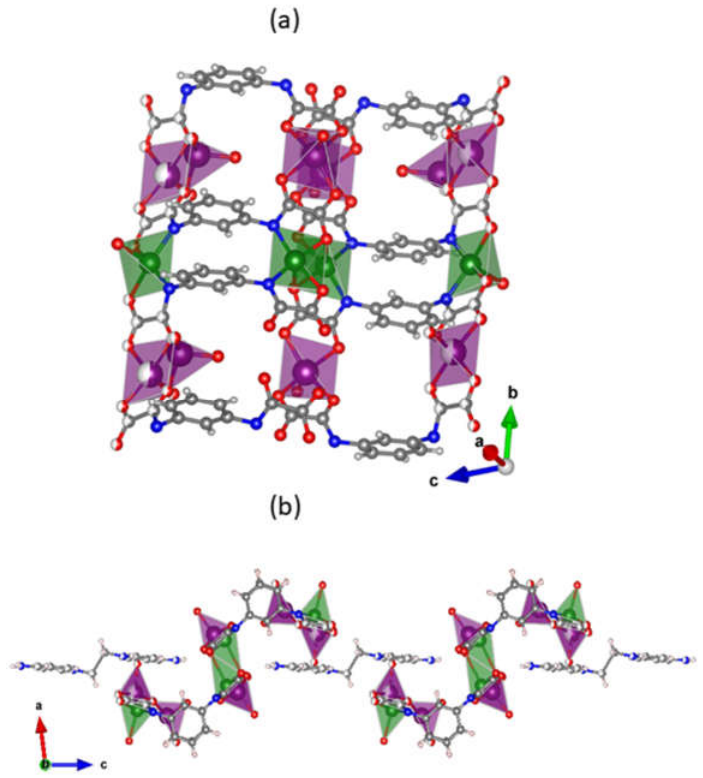
Figure 2. ( a ) Fragment of the {Li 6 (H 2 O) 8 [Cu 4 ( µ -mpba) 4 (H 2 O) 2 ]} 2 − 1D coordination polymer growing parallel to the crystallographic b axis featuring the coordination polyhedra of the metal ions [color code: purple for lithium(I) and green for copper(II)]. ( b ) Crystal packing of 1 along the crystallographic c axis showing the {Li 6 (H 2 O) 8 [Cu 4 ( µ -mpba) 4 (H 2 O) 2 ]} 2 − units separated by the EDAP 2+ cations which create bridges between coordination polymers via hydrogen bonds. Atomic displacement ellipsoids of 2 can be found in the Supplementary Information, Figure S6.